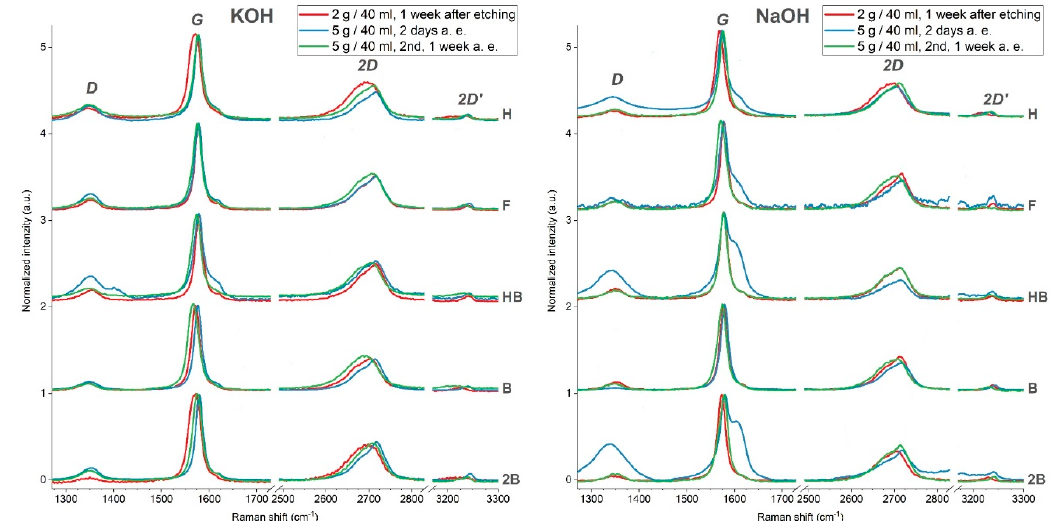
Figure 1. Comparison of Raman spectra of polymer graphite rods of different hardness etched: in 2 g / 40 mL (one set) and 5 g / 40 mL KOH solution; two sets of experiments ( left ) and secondly ( right ), they were etched in 2 g / 40 mL (one set) and 5 g / 40 mL NaOH solution. Raman spectra were captured two days or one week after etching, as indicated.